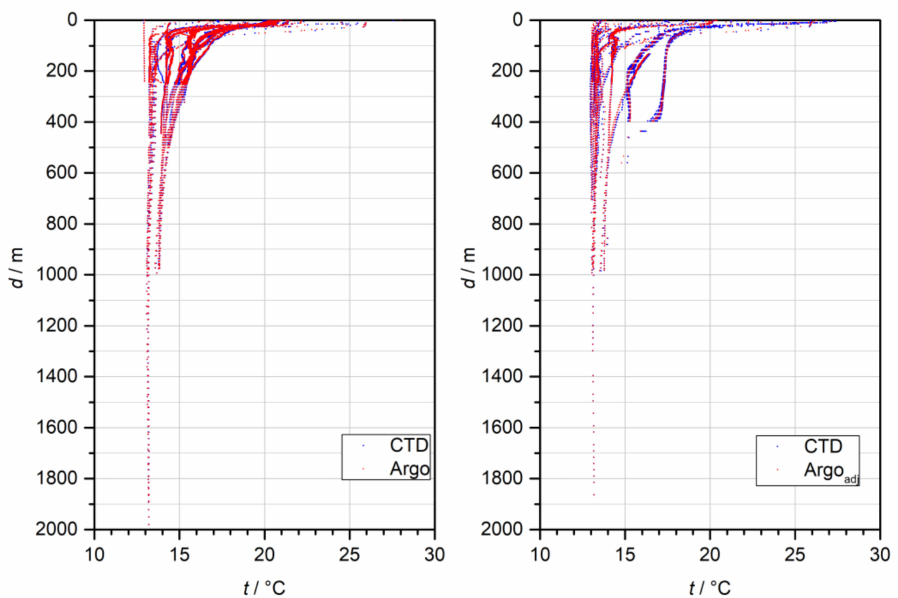
Figure 12. Overall Argo (red dots: not-adjusted, left , and adjusted, right ) and CTD (blue dots) matched temperature profiles.